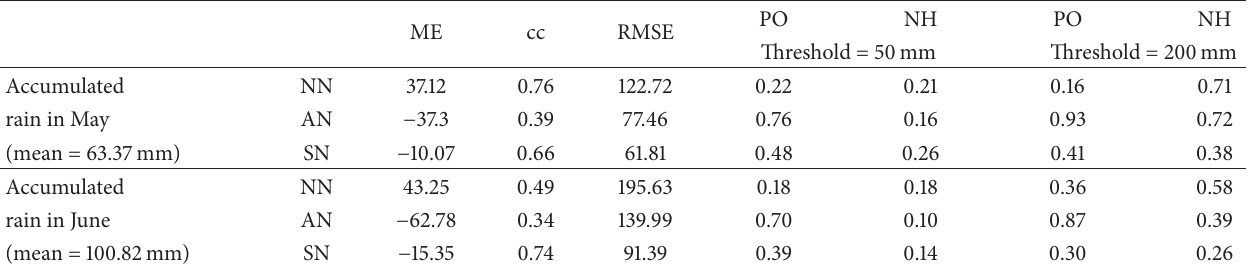
Table 1: Summary of the mean error (ME), the root mean square error (RMSE), the correlation coefficient (cc), PO, and NH at the threshold of 50 mm and 200mm for monthly accumulated precipitation in May and June,